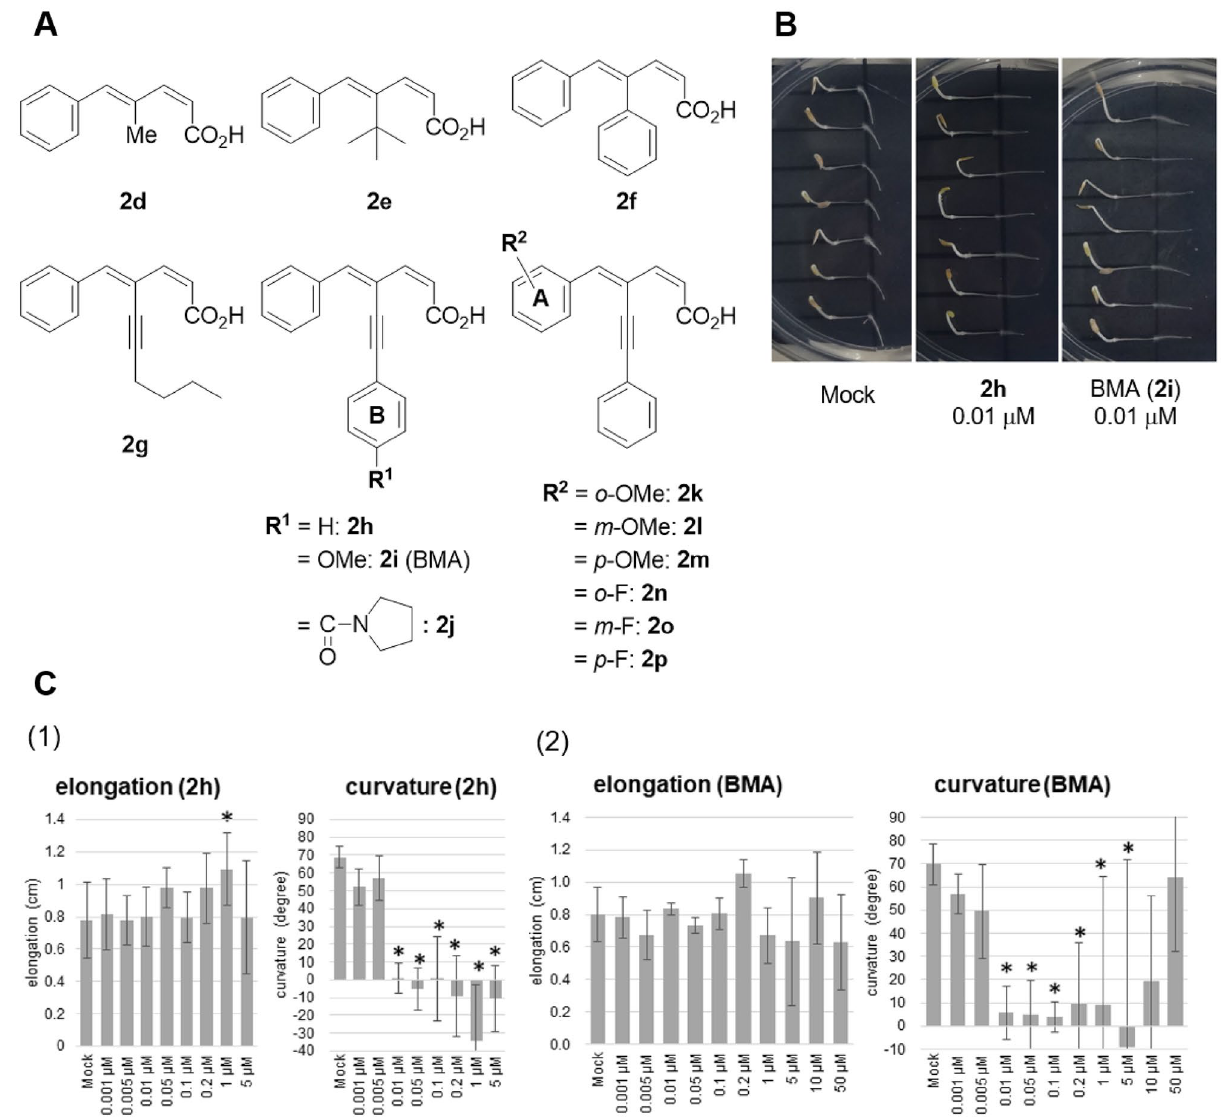
Figure 3. Gravitropic bending inhibitory tests of C4-carbon substituted analogs of ku-76 using lettuce roots. ( A ) Structure of synthetic compounds: methyl ( 2d ), tert -butyl ( 2e ), phenyl ( 2f ), 1-hexynyl ( 2g ), and phenylethynyl ( 2h – 2p ) compounds. ( B ) Representative images of inhibitory activity test of gravitropic bending for Mock, 2h , and 2i (BMA). ( C ) Inhibitory activity tests of gravitropic bending and elongation for dose– response relationship study for (1) 2h and (2) 2i (BMA). On the y-axis, the values of gravitropic bending (right) and elongation (left) represent mean ± SD. The asterisk indicates statistically significant differences between treatments and Mock at p < 0.05 (Turkey-Kramer’s